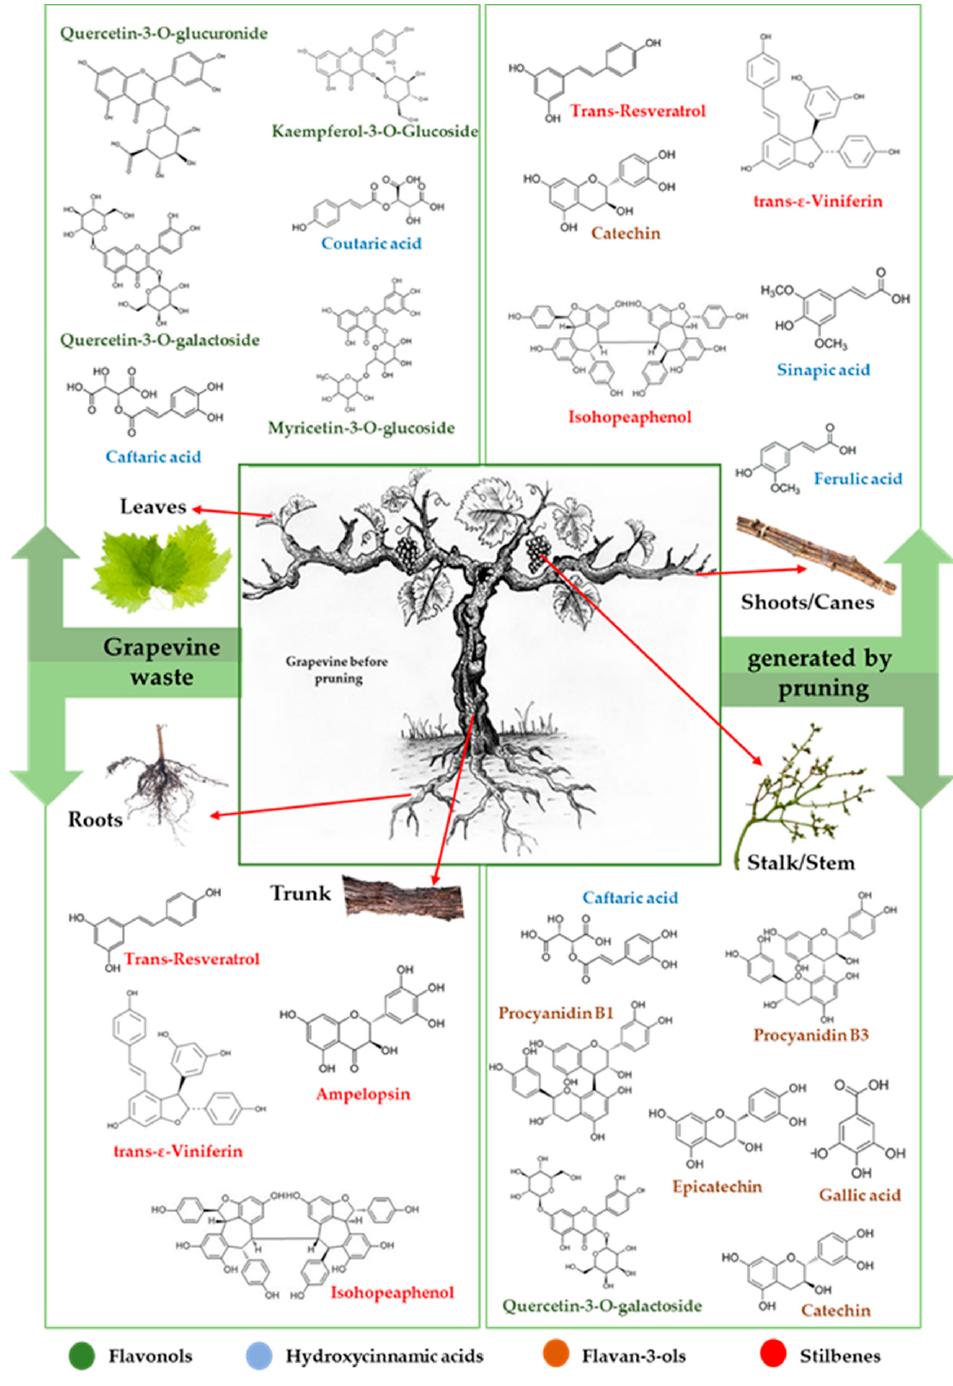
Figure 3. The most abundant polyphenols found in grapevine waste.